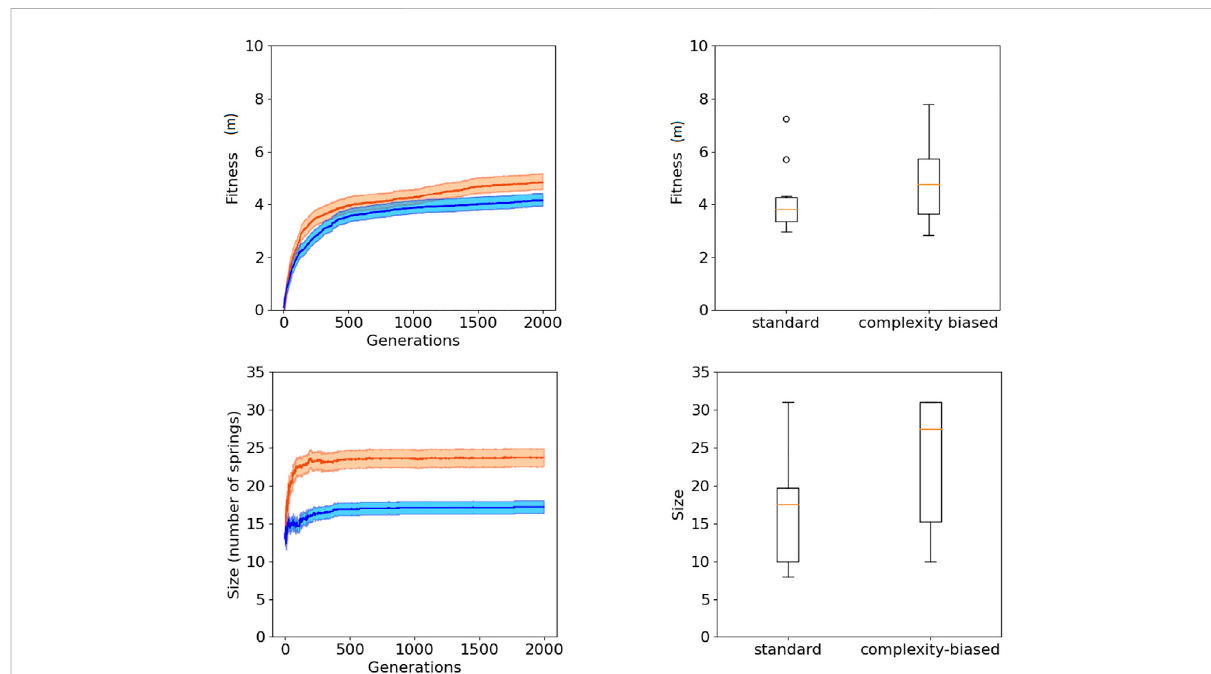
FIGURE 3 Fitness (top) and phenotypic complexity (bottom) in the case of the experiments performed with the (1 +4) evolutionary strategy. The data showninblueandredcorrespondtotheexperimentsperformedwiththestandardandcomplexity-biasedalgorithm,respectively.Datacollectedby running 10 replicationsof each experiment. Mean and 75% bootstrapped con fi dence intervals of the mean (shadow area) across 10 replications. The top-left fi gure shows the performance of the best individuals of each generation, averaged over 10 replications. The top-right fi gure shows the distribution of performance of the best 10 robots obtained in 10 corresponding replications of the experiment. The bottom-left fi gure shows the average phenotypic size of the best robots across generations. The bottom-right fi gure shows the distribution of phenotypical size of the 10 best robots obtained in the 10 corresponding replications of the experiment. The boxes represent the interquartile range of the data and horizontal lines inside the boxes mark the median values. The whiskers extend to the most extreme data points within 1.5 times the interquartile range from the